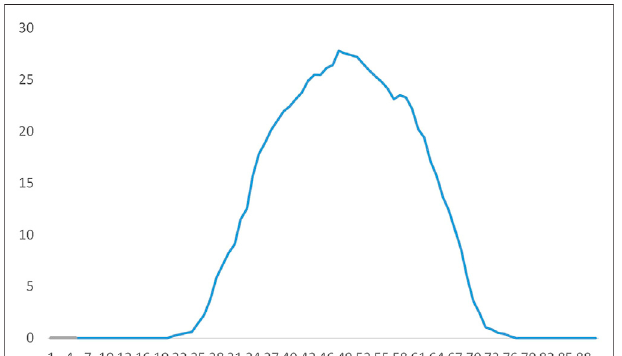
FIGURE 2 | The PV curve of the